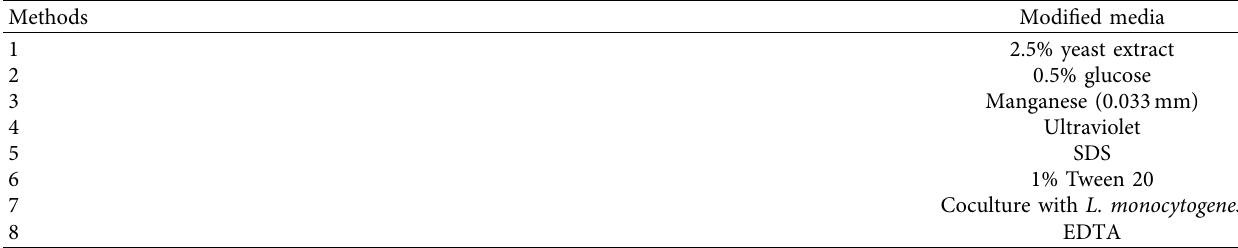
Table 1: The different culture conditions for the evaluated strains.